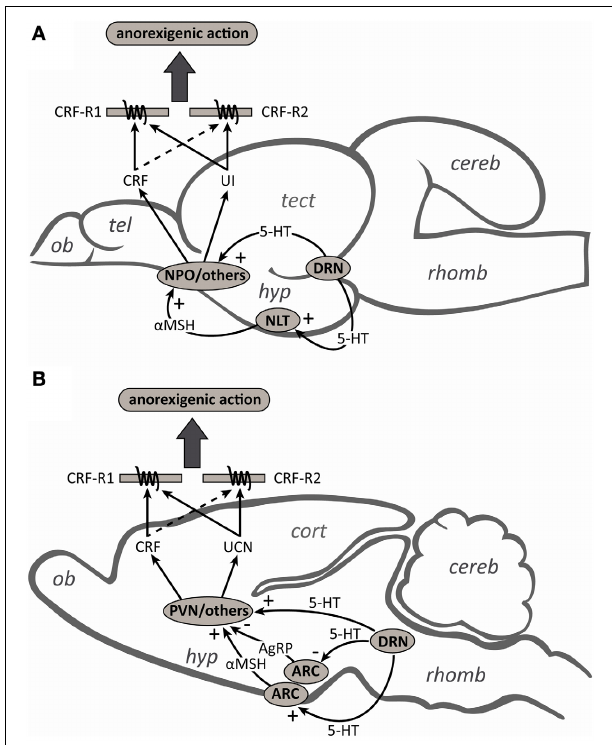
FIGURE 6 | Schematic diagrams of midsagittal sections through (A) the rainbow trout and (B) rat brains to summarize the contributions and interactions of the serotonergic and corticotropin-releasing factor (CRF) systems in the regulation of food intake. Serotonergic (5-HT) neurons from the dorsal raphe nucleus (DRN) can directly stimulate the release of CRF from the nucleus preoptic (NPO) and paraventricular nucleus (PVN) in fish and mammals, respectively. In mammals, 5-HT neurons also activate arcuate nucleus (ARC) neurons to facilitate the release of the melanocortin 4 receptor (MC4R) agonist α -melanocyte-stimulating hormone ( α MSH) and inhibit the release of the MC4R antagonist agouti-related peptide (AgRP). CRF neurons in the PVN act as a downstream mediator of MC4R signaling and contribute to the regulation of food intake. In fish, while the anorexigenic actions of α MSH also appear to be mediated by the CRF-signaling pathway, the interactions between 5-HT and the melanocortin system have yet to be investigated. Also unknown are the roles of urotensin I (UI) and urocortin (UCN) secreting neurons as mediators of either the direct or indirect anorexigenic actions of 5-HT. Although CRF and UI/UCN have anorexigenic actions and both the CRF type 1 (CRF-R1) and type 2 (CRF-R2) receptors have been implicated in the regulation of food intake, the higher affinity of UI/UCN than CRF for CRF-R2 likely explains why UI/UCN more potently inhibits food intake than CRF (see text for further details). Abbreviations: cereb, cerebellum; cort, cerebral cortex; hyp, hypothalamus; NLT, nucleus lateralis tuberis; ob, olfactory bulb; rhomb, rhombencephalon; tect, optic tectum; tel,